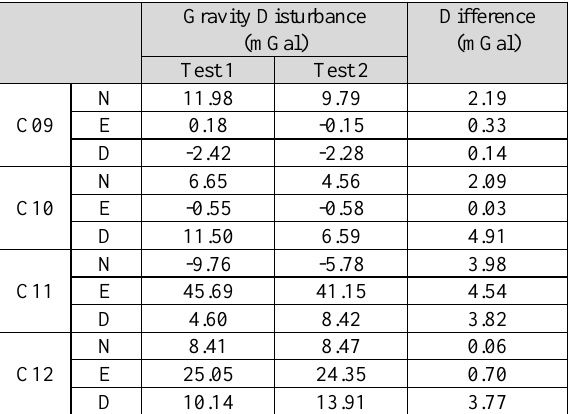
Table 4. The statistics of INS/GNSS gravimetry with UAS in the ZUPT